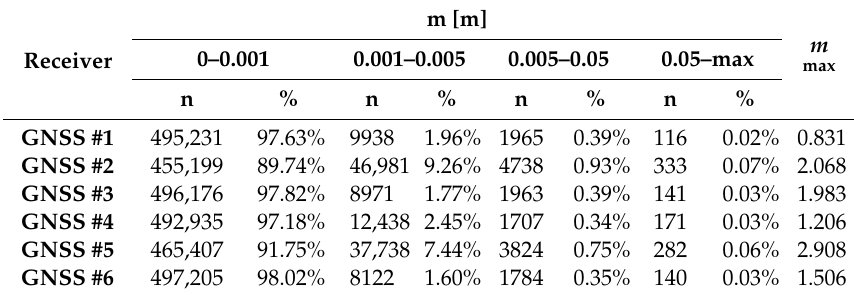
m max 0–0.001 0.001–0.005 0.005–0.05